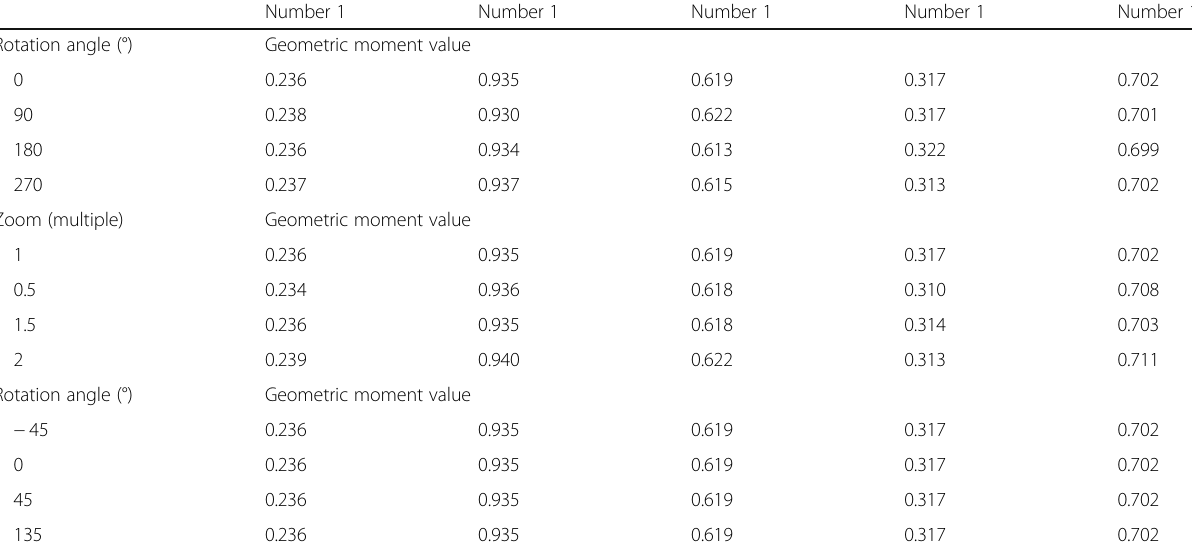
Table 1 Verification of geometric